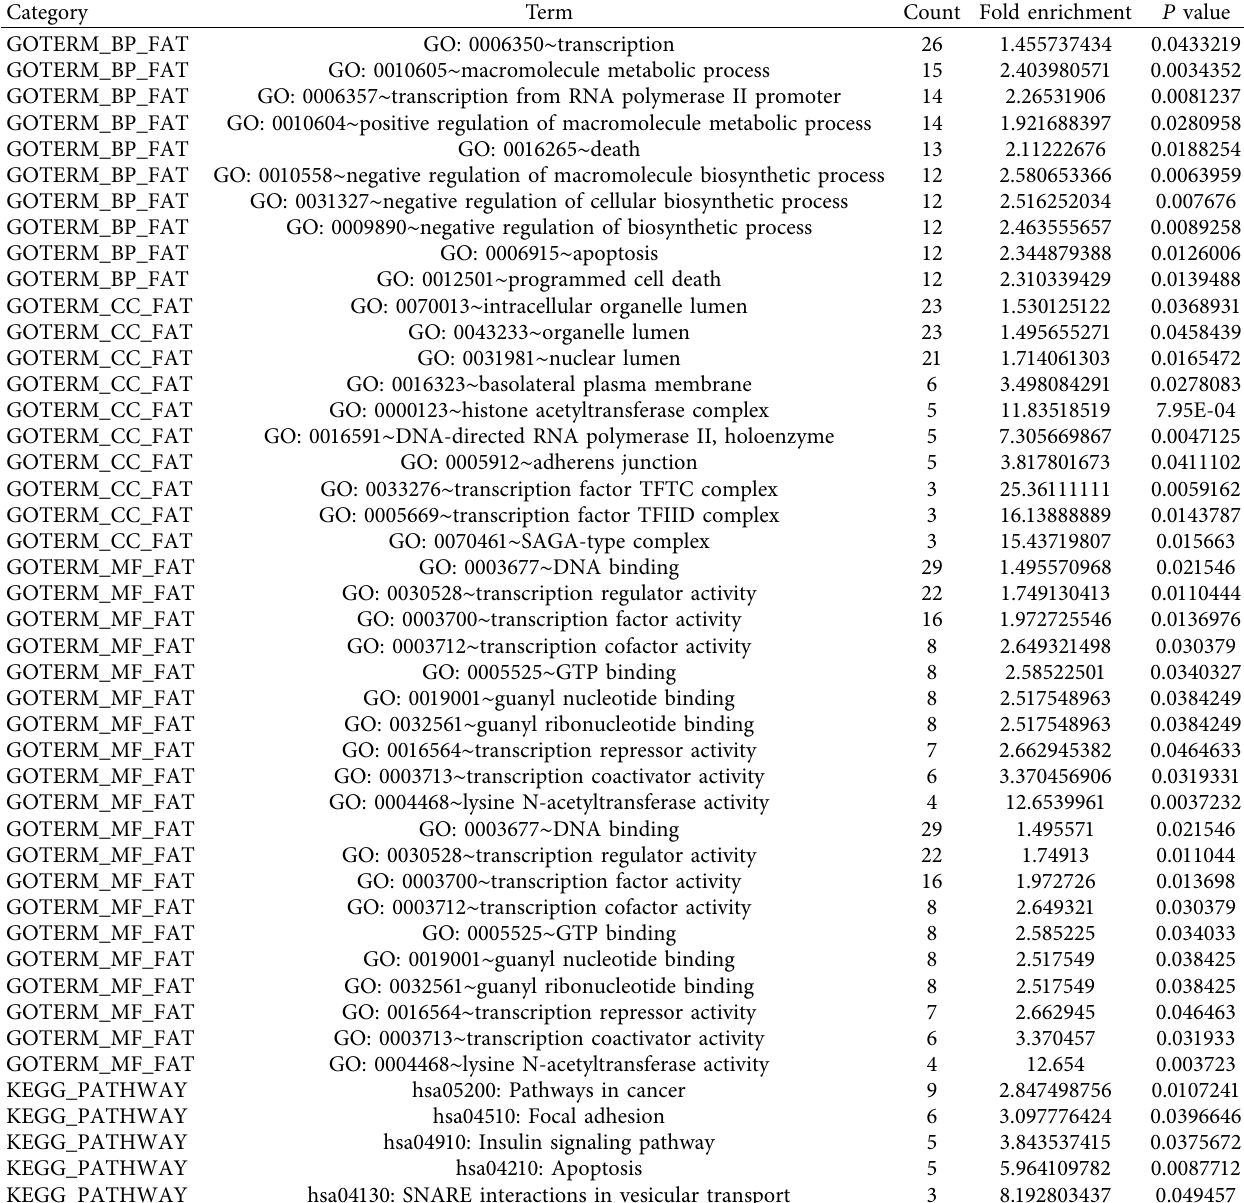
Table 1: Functional analysis of the intersected